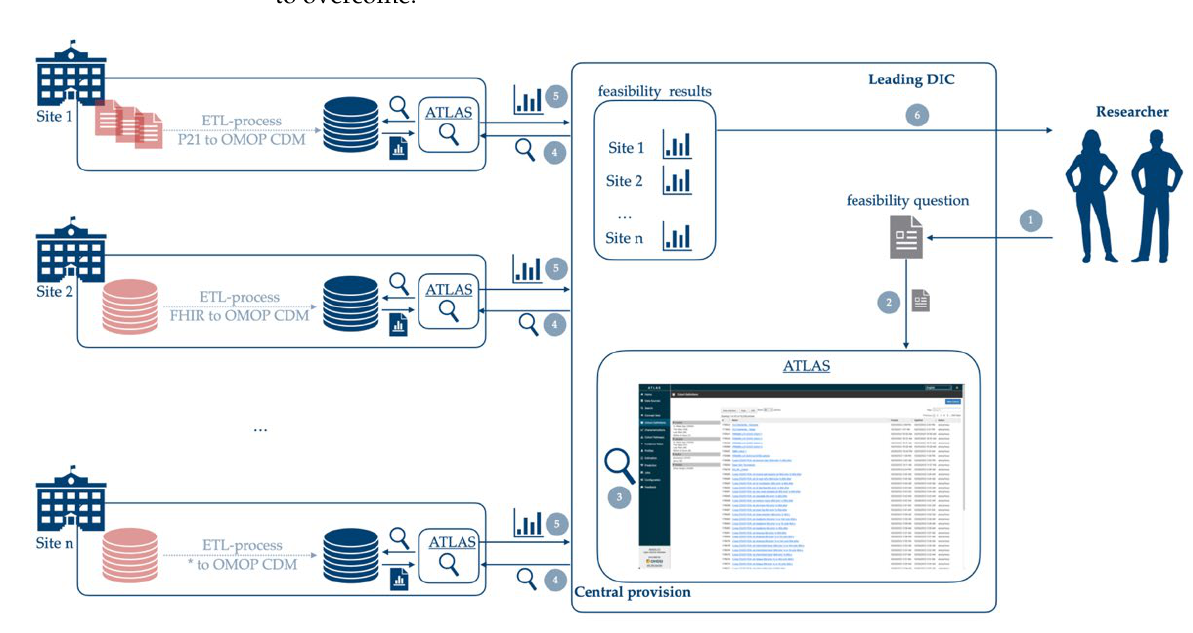
Figure 1. Technical architecture: Researcher poses a feasibility question to a leading data integration center (DIC) (1). A medical informatics specialist formalizes the feasibility question (2). Then the specialist builds and exports corresponding cohorts in ATLAS (3) and sends them to participating sites (4). The participating sites import the cohort and generate results, which are then sent back to the leading DIC (5). The leading DIC combines the results, pseudonymizes the sites and provide this result to the requesting researcher (6).